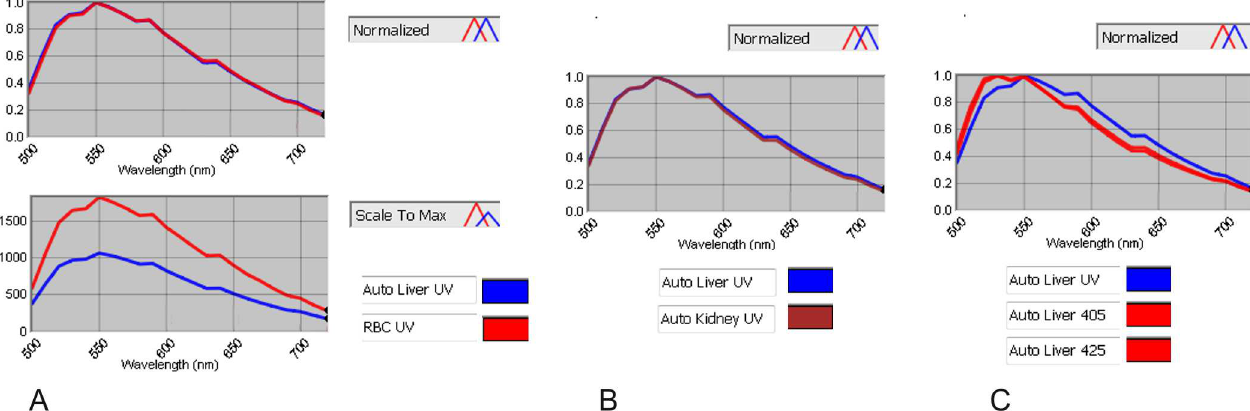
Fig 3. Comparison of the spectraof autofluorescence in FFPE liver, red bloodcells (RBC)and FFPE kidney. A: spectra of red blood cells (RBC—red) and liver autofluorescence (AUTO Liver—blue) using a normalisedscale (A top panel)and with unnormalised scale (A bottompanel). B: spectra for liver and kidney autofluorescence (AUTO Liver- blue; AUTO Kidney- red)using a normalised scale. C: spectra for liver autofluorescence excited by mercurylight (blue) or LED 405 & 425 (bothred).Autofluorescenceof FFPE liver and RBC have a similarspectrum (A- top: overlapping curves)but differentintensity(A bottom). FFPE liver and kidney have a similarspectrumof autofluorescence (B)–(A,B are shown for mercurylight illumination; similarresultswere obtainedwith LED illumination). Autofluorescencespectrumof tissue illuminated with UV and LED are different(C). All were performed using the Qdot filterand autofluorescence spectra could be distinctwith a differentexcitation range.